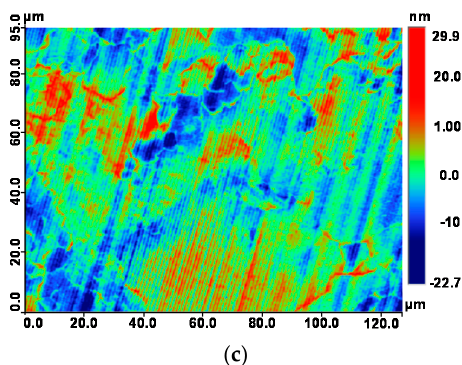
Figure 4. Finished high-purity polycrystalline aluminum pin mold: ( a ) photograph of the processed sample of the pin mold, ( b ) edge profile of the processed sample, and ( c ) surface roughness of the polycrystalline aluminum pin mold (Sa = 3.632 nm).